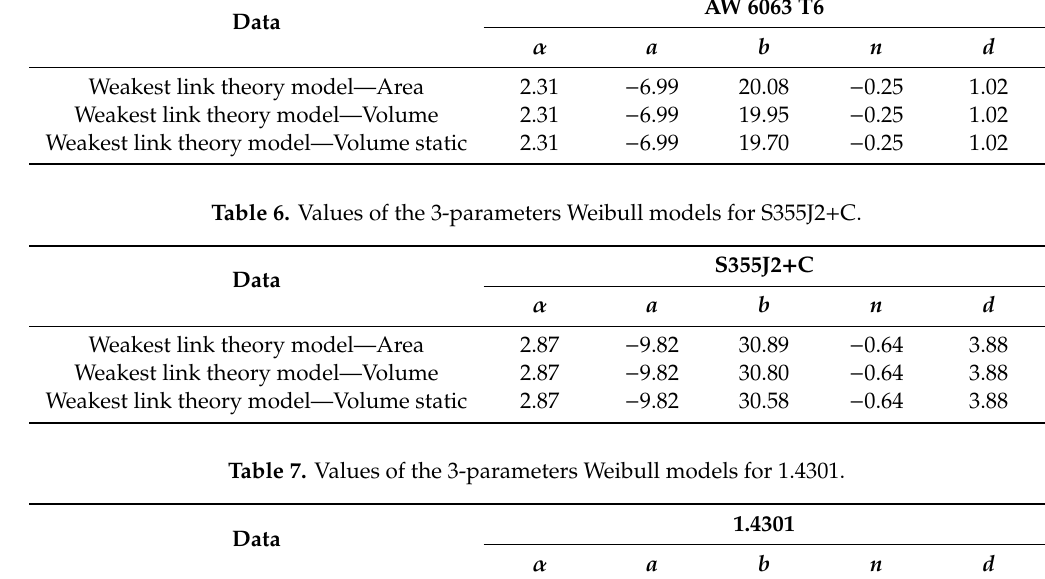
Table 5. Values of the 3-parameters Weibull models for AW 6063 T6.